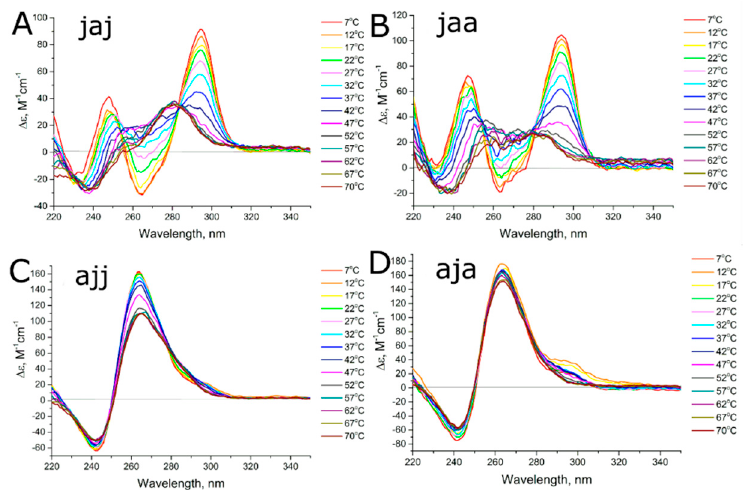
Figure 4. CD spectra of thermal melting of hybrid aptamers ( A ) jaj, ( B ) jaa, ( C ) ajj, and ( D ) aja.